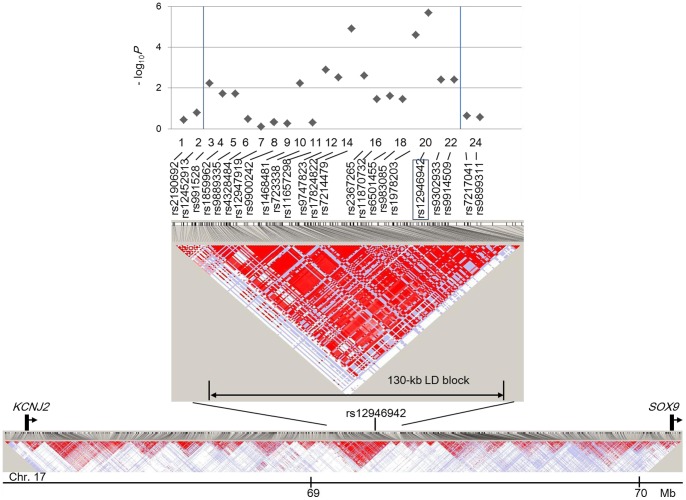
Linkage disequilibrium (LD) map and P-value plot of the severe adolescent idiopathic scoliosis susceptibility locus at chromosome 17q24.3.Top panel: The association results shown as – log10 of minimum P values in allele, recessive and dominant models and a focus view of the 130-kb LD block including rs12946942. All SNPs are analyzed in GWAS. Two vertical lines in this graph indicate the range of the LD block. rs12946942 is boxed. Middle panel: The ∼2 Mb LD map (D') around rs12946942 is shown using loci with MAF >0.10 from Phase II HapMap (release 24) JPT individuals. LD score: (dark red) LOD >2, D' = 1; (light red) LOD >2, D'<1; (blue) LOD <2, D' = 1; (white) LOD <2, D'<1. Bottom panel: The position of rs12946942 and the two candidate genes (KCNJ2 and SOX9) on chromosome (Chr.) 17.